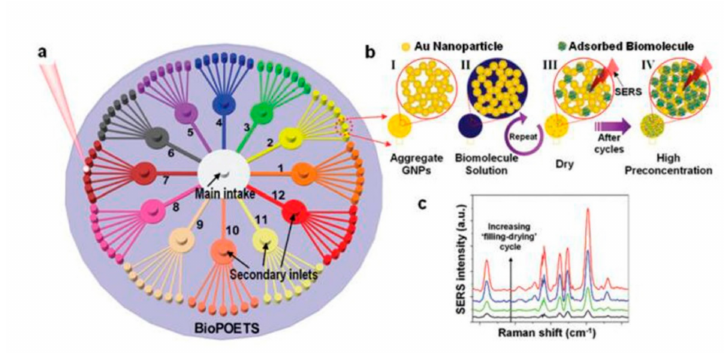
Figure 13. Optofluidic SERS-CD platform and preconcentration mechanism. ( a ) Schematic illustration of the optofluidic SERS-CD platform with high-throughput sample preparation; ( b ) The mechanism of preconcentration consisting of 4